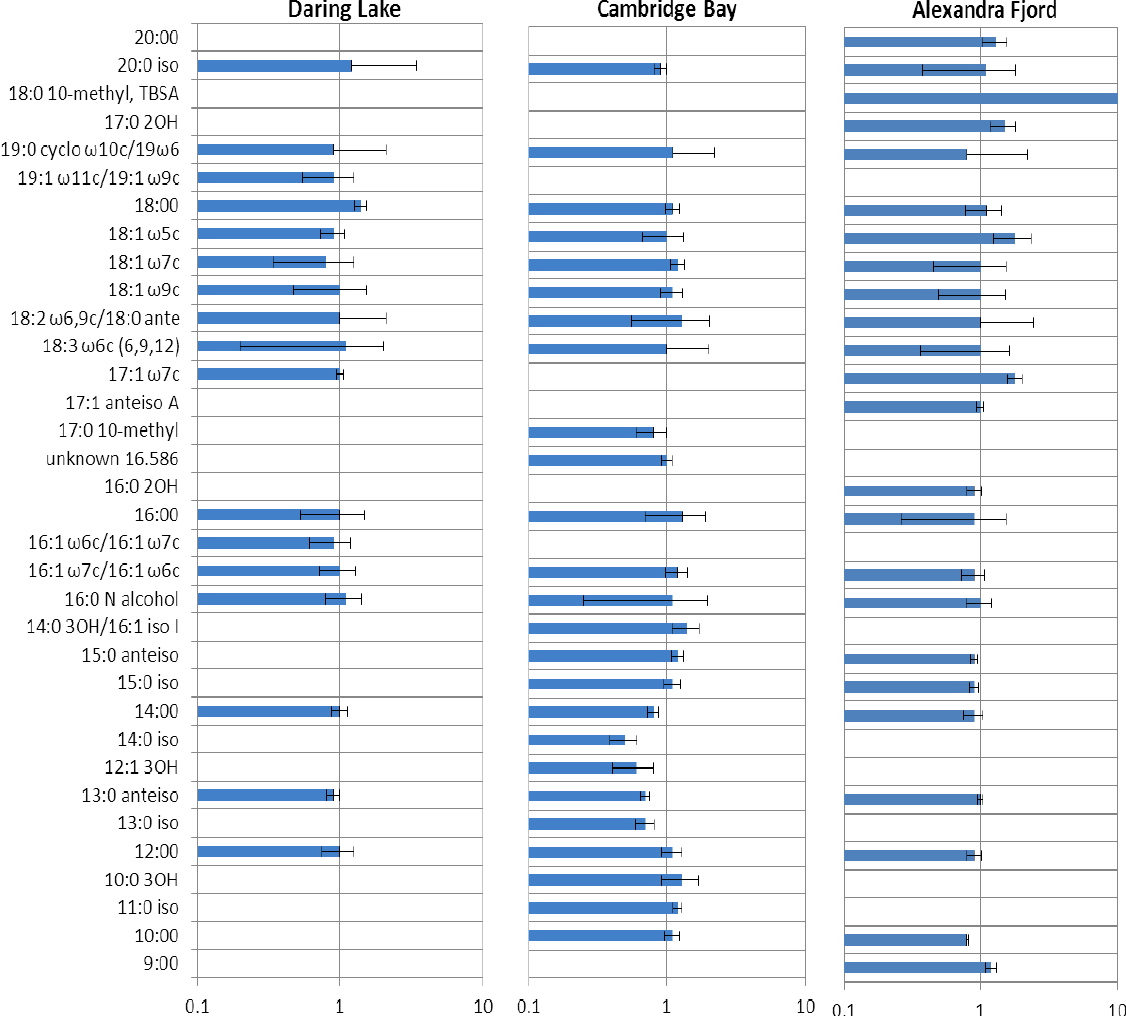
Figure 2. Mean ratios of the most abundant fatty acids (>1% of chromatographic peak areas) from low arctic (Daring Lake), mid arctic (Cambridge Bay) and high arctic (Alexandra Fjord) soils, both before and after daily freeze-thaw treatments for 14 days. Freeze-thaw-treated (n = 3) /untreated (n = 3) are represented along with standard errors (lines on the bars), with no change in mean abundance after treatment indicated by